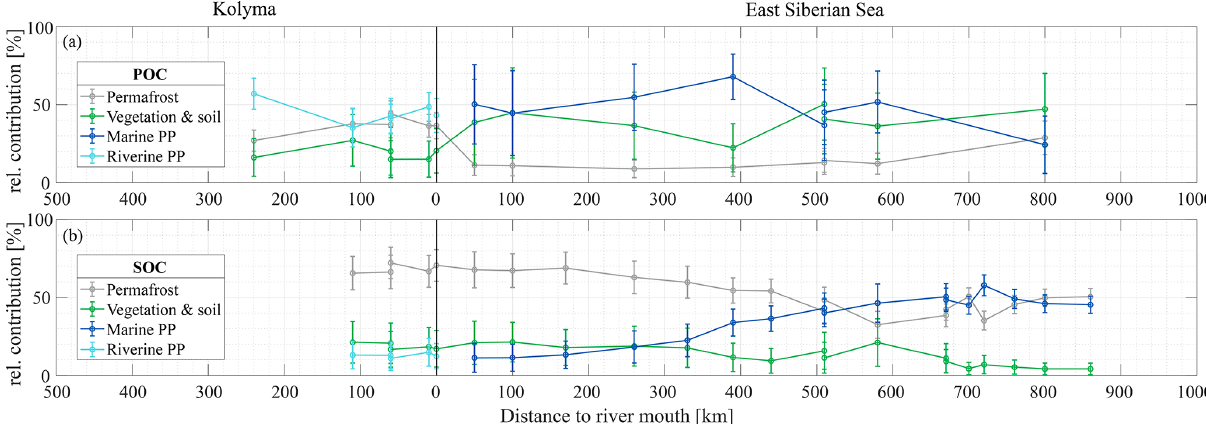
Figure 4. Mean relative contribution ( ± standard deviation from Monte Carlo simulations) of three endmembers over transect distance for (a) surface water particulate organic carbon (POC) and (b) sediment organic carbon (SOC), based on dual carbon isotope ( (cid:49) 14 C and δ 13 C) endmember analyses. For the riverine part of the transect (Kolyma; left side of the figure), the endmembers are: Permafrost organic carbon (OC) in grey, Vegetation/soil OC in green, and Riverine primary production (PP) OC in cyan. For the marine part of the transect (East Siberian Sea; right side of the figure), the endmembers are: Permafrost OC in grey, Vegetation/soil OC in green, and Marine primary production OC in dark blue. Definition of the endmembers are described in Sect. 2.6 and can be seen Fig.